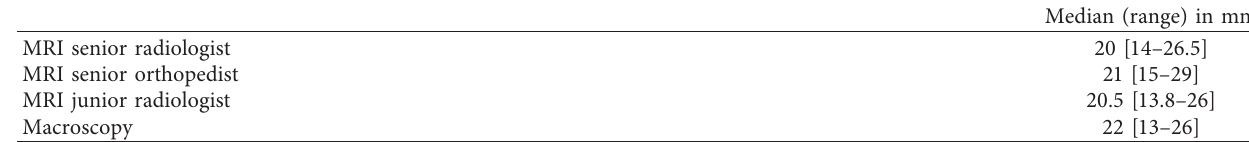
Table 2: Equivalence between MRI and macroscopic evaluation (Kruskal–Wallis one-way analysis of variance on ranks) ( n �